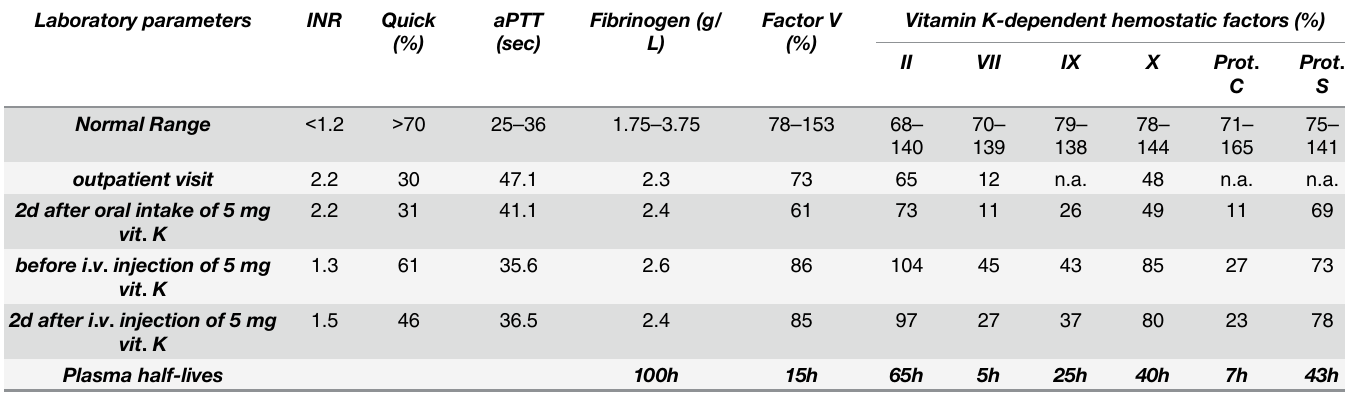
Table 4 shows laboratory evaluation of coagulation parameters including individual pro- and anticoagulant factors in patient 14.1 during an outpatient routine control, 2 days (2d) after oral intake of 5 mg vitamin K (vit. K), and immediately before and 2d after intravenous (i.v.) application of 5 mg vit. K. Neither of the two vit. K applications led to an increase of vitamin K-dependent factors (FII, VII, IX, X, protein C and S). Moreover, also the non-vitamin-K- dependent factor V was reduced in the fi rst two blood examinations, thus suggesting an impaired synthetic function of the liver as reason for diminished plasmatic coagulation factors and not a vitamin K de fi